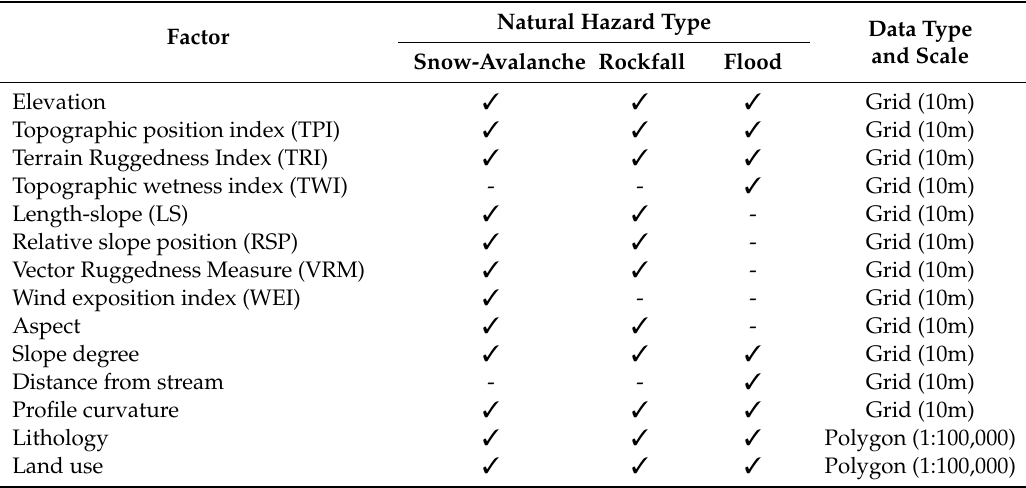
Table 2. The spatial database of predictive